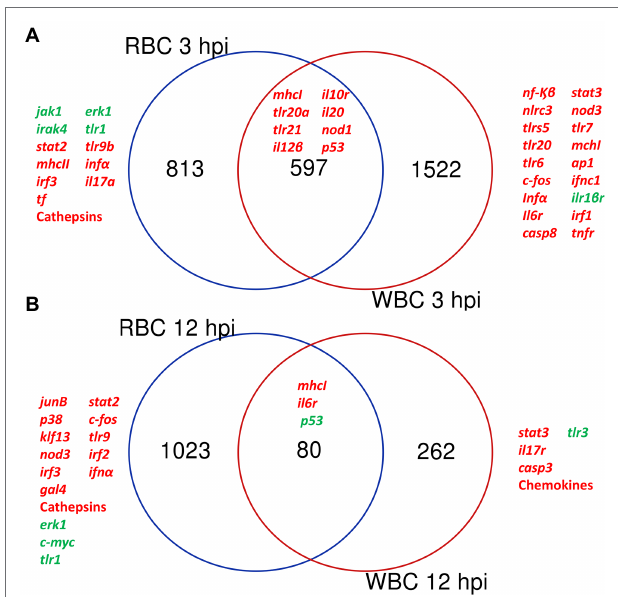
FIGURE 2 | Red blood cells (RBCs) and white blood cells (WBCs) elicit a different immune response against V. vulnificus . Venn diagram depicting the overlap of the differentially expressed genes (DEGs) between RBCs and WBCs at 3 hpi (A) and 12 hpi (B)